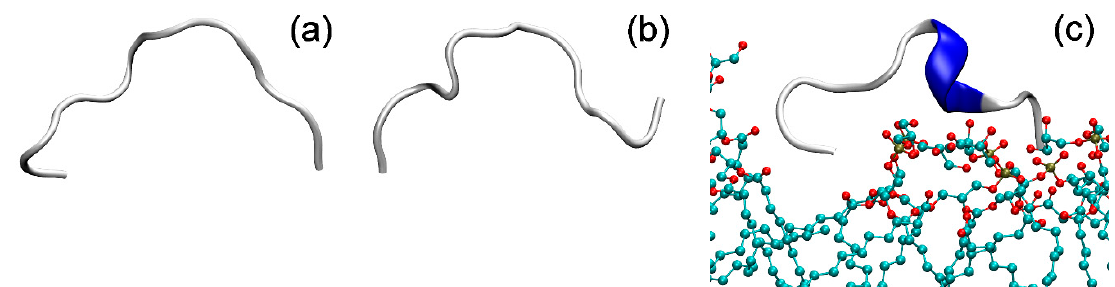
Figure 11. Molecular mechanic simulation of HAL-1 peptide ( a ) in water, ( b ) in the presence of PC and ( c ) PG model membrane.